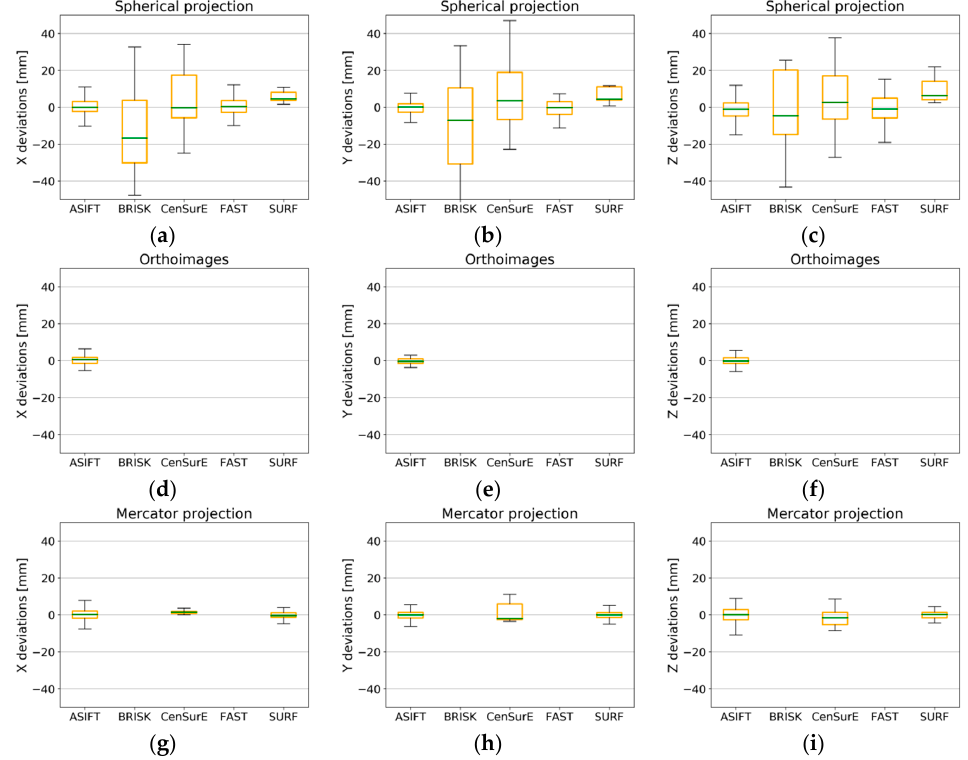
Figure 22. Box plots for the distribution of the deviations of natural check points for all pairs of fully registered scans (without points used for the ICP and non-registration) for Test Site IV. The spherical projection: component—x ( a ), y ( b ), and z ( c ); orthoimages: component—x ( d ), y ( e ), and z ( f ); the Mercator projection: component—x ( g ), y ( h ), and z ( i ).